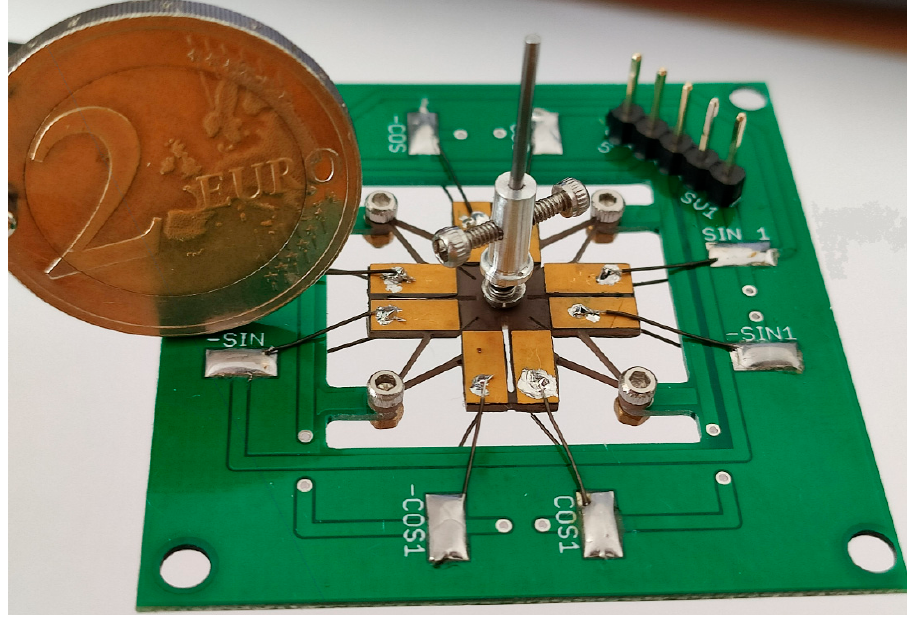
Figure 10. A prototype of the piezoelectric motor mounted into the printed circuit.